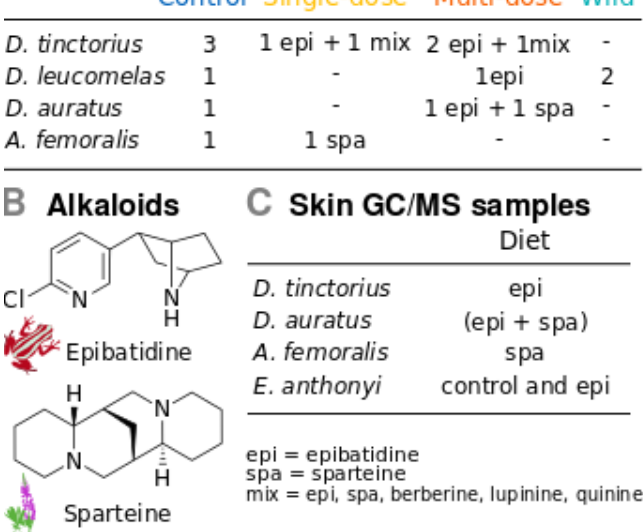
Figure 1. Experimental design. A. Sample sizes per treatment and species used for RNA-